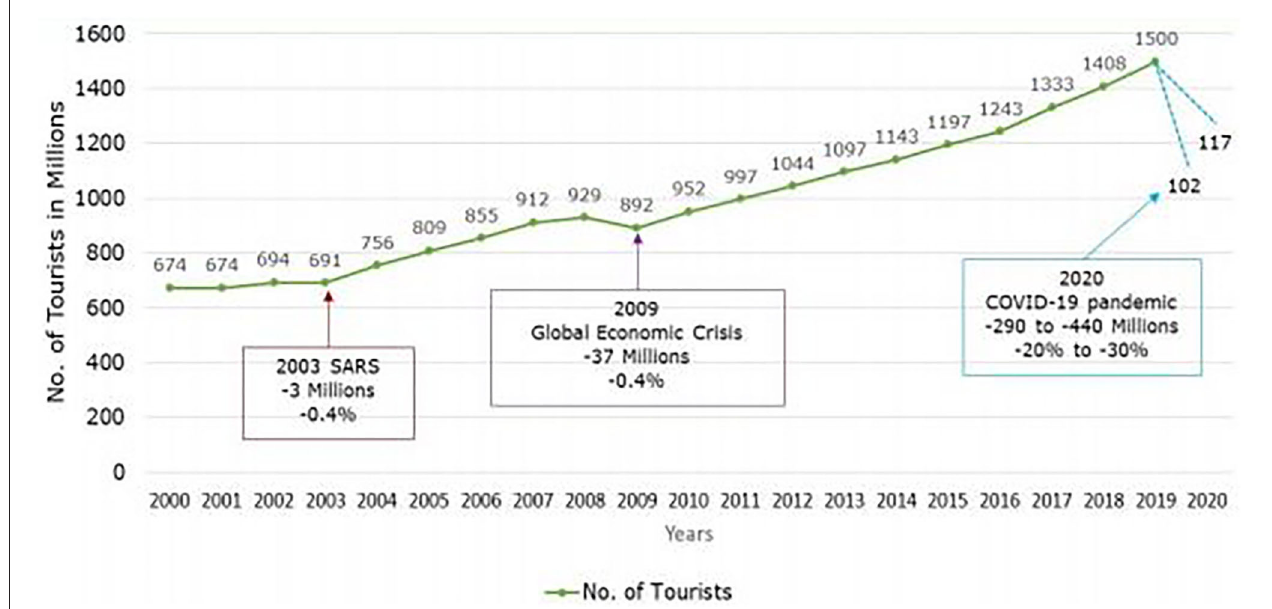
FIGURE 1 | Number of tourists in the world. UNWTO